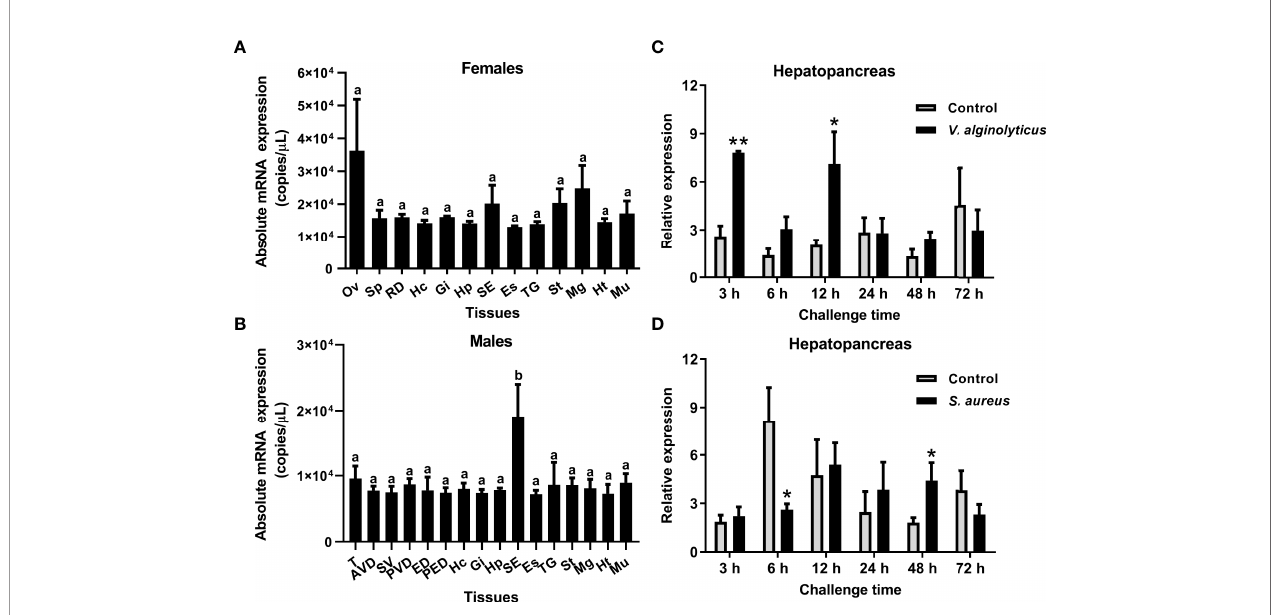
FIGURE 2 | Gene expression pro fi les of SpCrus8 in S. paramamosain . Tissue distribution of SpCrus8 in females (A) and males (B) crabs (n=5). The expression pattern of SpCrus8 in male hepatopancreas after V. alginolyticus (C) and S. aureus (D) challenge (n=5). Differences in different tissues were indicated with the letter “ a ” or “ b ” . Signi fi cant difference between the control and bacterial challenge groups was indicated with asterisks, *p < 0.05, **p < 0.01. Abbreviations: Ov, ovaries; Sp: spermathecae; RD, reproductive duct; Hc, hemocytes; Gi, gills; Hp, hepatopancreas; SE, subcuticular epidermis; Es, eyestalk; TG, thoracic ganglion; St, stomach; Mg, midgut; Ht, heart; Mu, muscle; T, testis; AVD, anterior vas deferens; SV, seminal vesicle; PVD, posterior vas deferens; ED, ejaculatory duct; PED, posterior ejaculatory